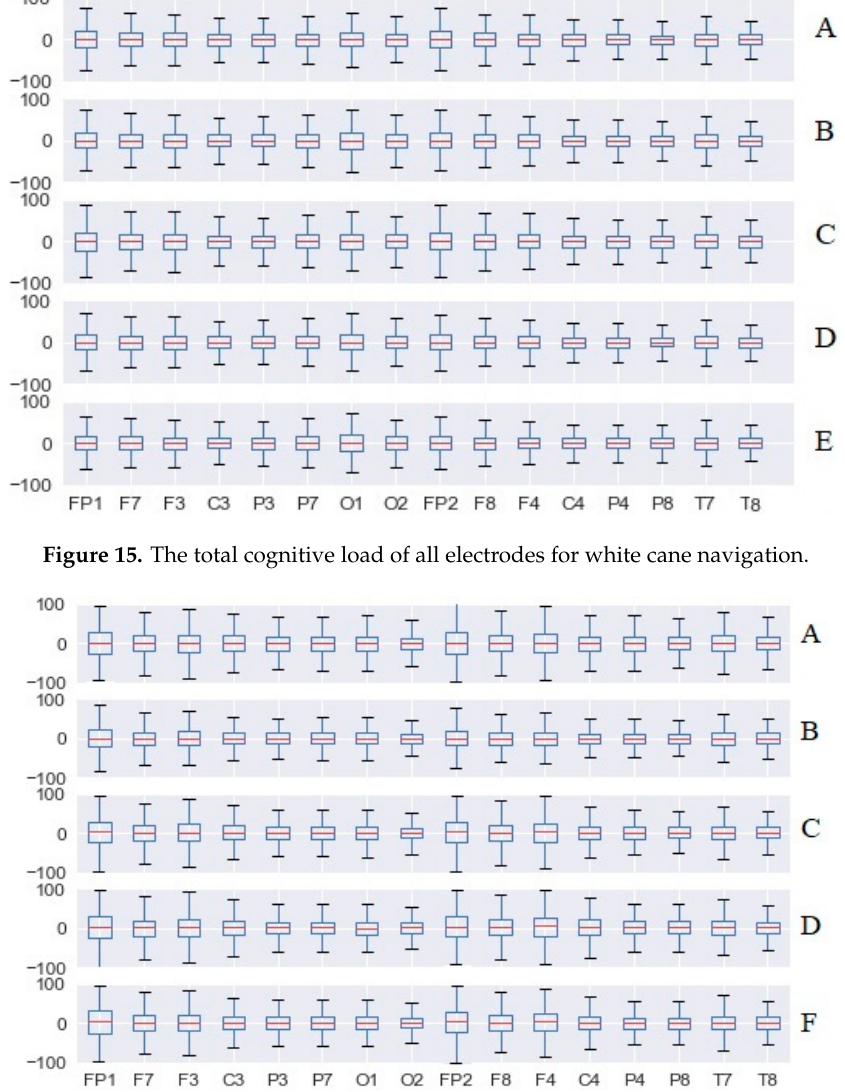
Figure 16. The total cognitive load of all electrodes for Sound of Vision (SoV) navigation.